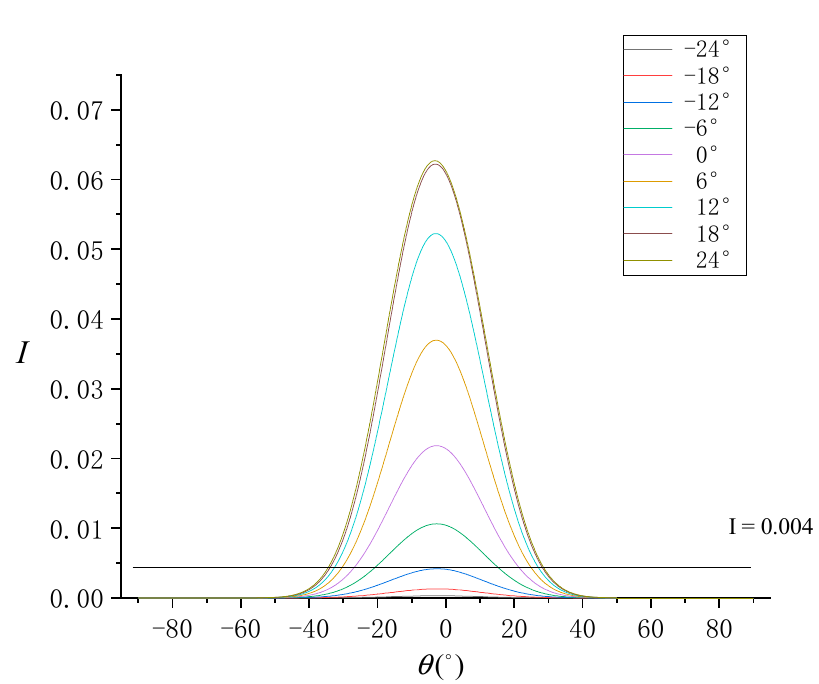
Figure 3. Normalized sun glitter (SG) radiance ( I ) simulated by each sensor view angle (SVA) ( θ ) under different pointing angles.